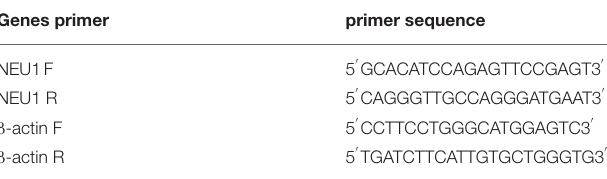
TABLE 2 | DNA Sequences of primers used for